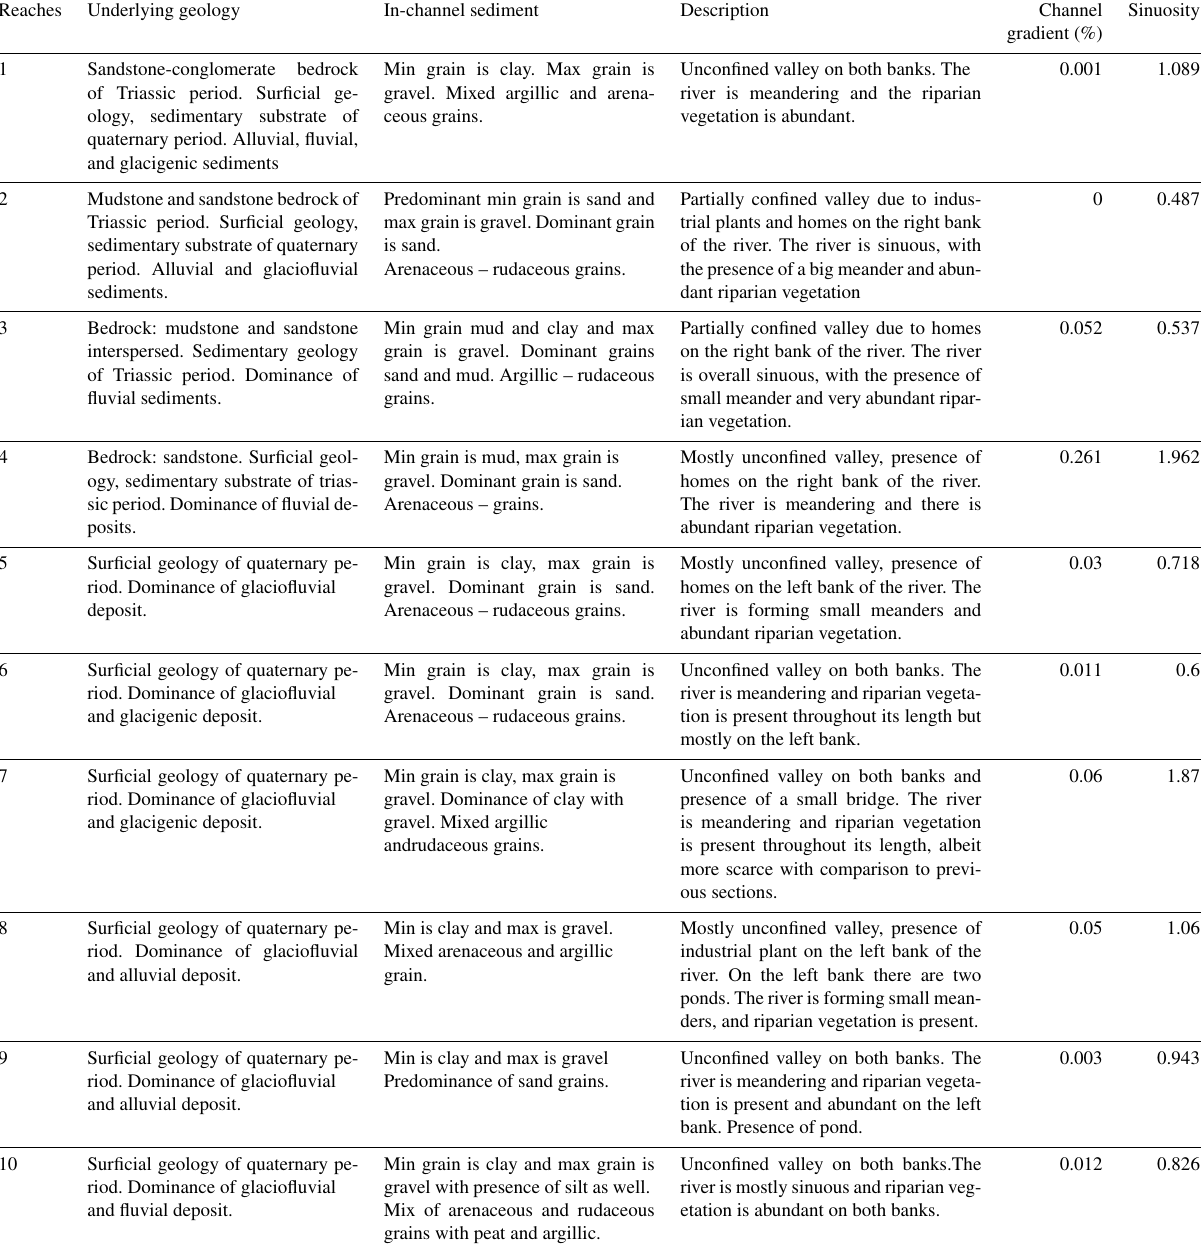
Table 2. Case study about the River Tern, UK (Sect. 8). The table describes the 10 reach sections obtained by dividing the river channel into sinuosity units based on changes in the axis of the overall planimetric course. The units that differed in sinuosity by more than 10% were considered separate reaches. Surface geology and valley type are evaluated with respect to the extent of lateral hyporheic exchange. The sections are enumerated and described from upstream to downstream. Geology information was extracted from the British Geological Survey